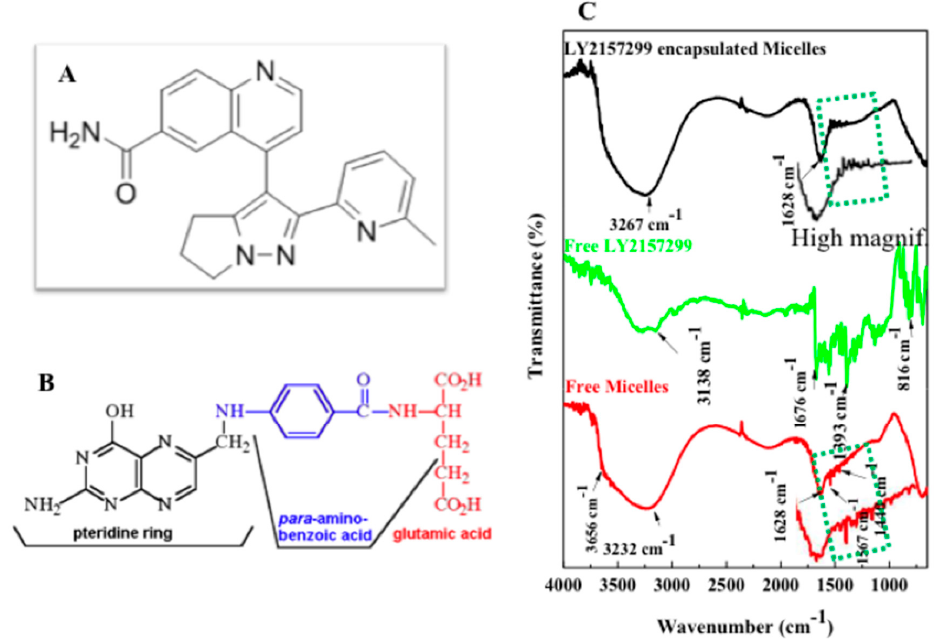
Figure 7. Bands Modification of Encapsulated LY2157299. ( A ) LY215299 structure; ( B ) Folic acid structure; ( C ) FTIR spectra of LY/LYfree micelles and LY-loaded micelles (squared dotted lines refer to selected bands).